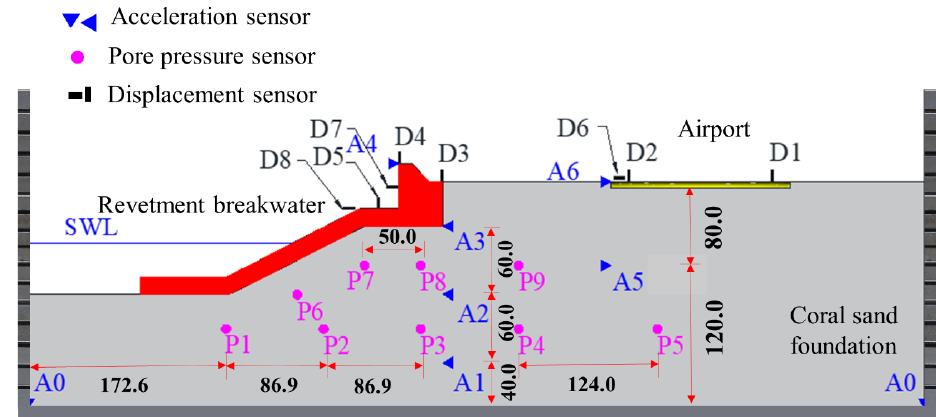
Figure 4. Layout of the measurement sensors in the physical model (Unit: mm).